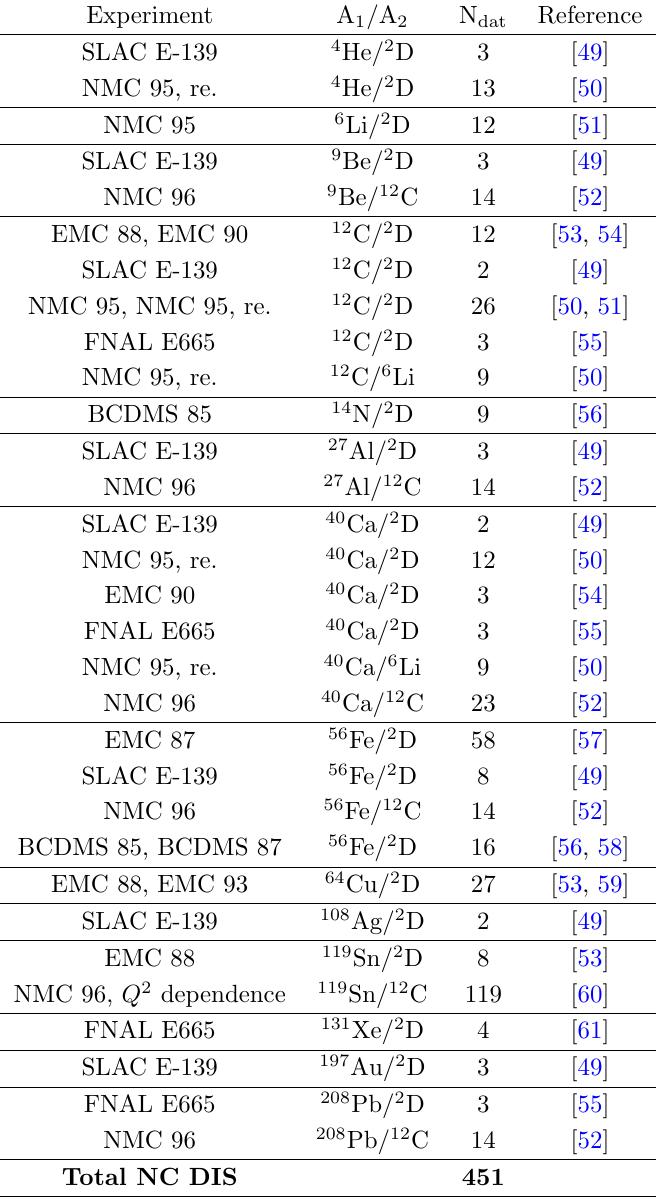
Table 1 . The neutral-current nuclear deep-inelastic input datasets included in nNNPDF2.0. For each dataset, we indicate the nuclei A 1 and A 2 involved, the number of data points that satisfy the baseline kinematical cuts, and the publication